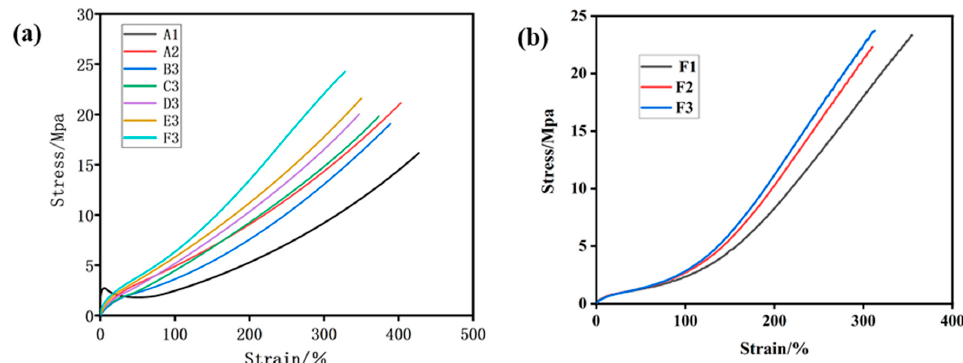
Figure 9. Mechanical properties of silica / SSBR / BR composites: ( a ) samples with di ff erent ESSBRs(epoxy degree), ( b ) samples with di ff erent content of E25. Table 6. Mechanical properties of silica / SSBR / BR composites.